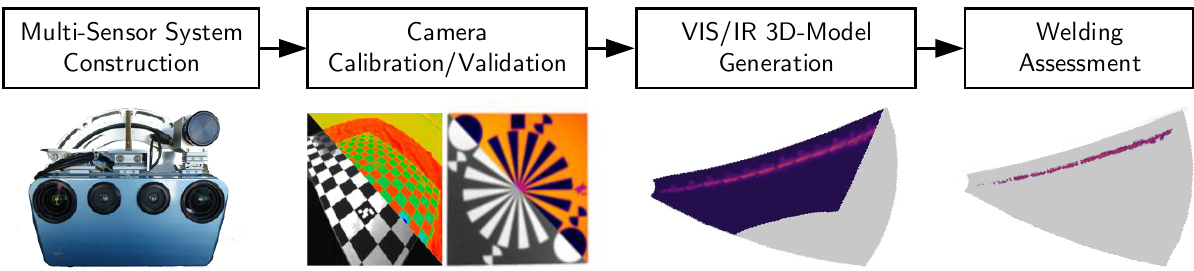
Figure 1. Proposed monitoring framework. Construction: hardware and software integration of a panchromatic stereo (VIS) and a long-wave infrared (IR) camera. Calibration/Validation: trifocal geometric calibration with an improved chessboard (left) and resolving power validation (right) of VIS and IR cameras. 3D-Model Generation: thermal-colored 3D point cloud model for each frame-set of the synchronized cameras ( 10 Hz ). The 3D model may be reinforced by a pre-created CAD model. Welding Assessment: Two common types of defects can be inferred if the measured surface temperature is greater or smaller than some pre-determined threshold values.